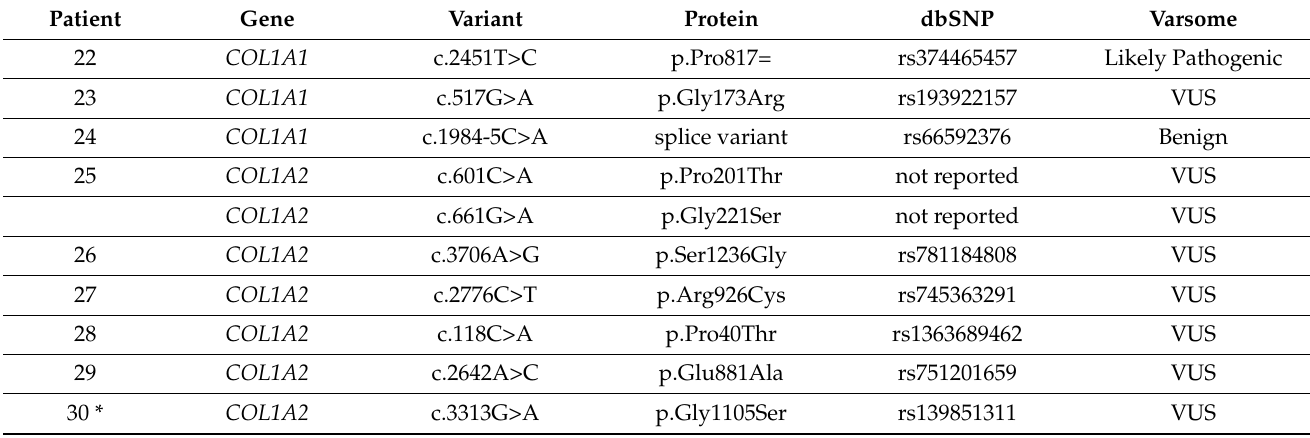
Table 3. Variants in COL1A1 and COL1A2 genes detected in the investigated group of patients with cEDS clinical